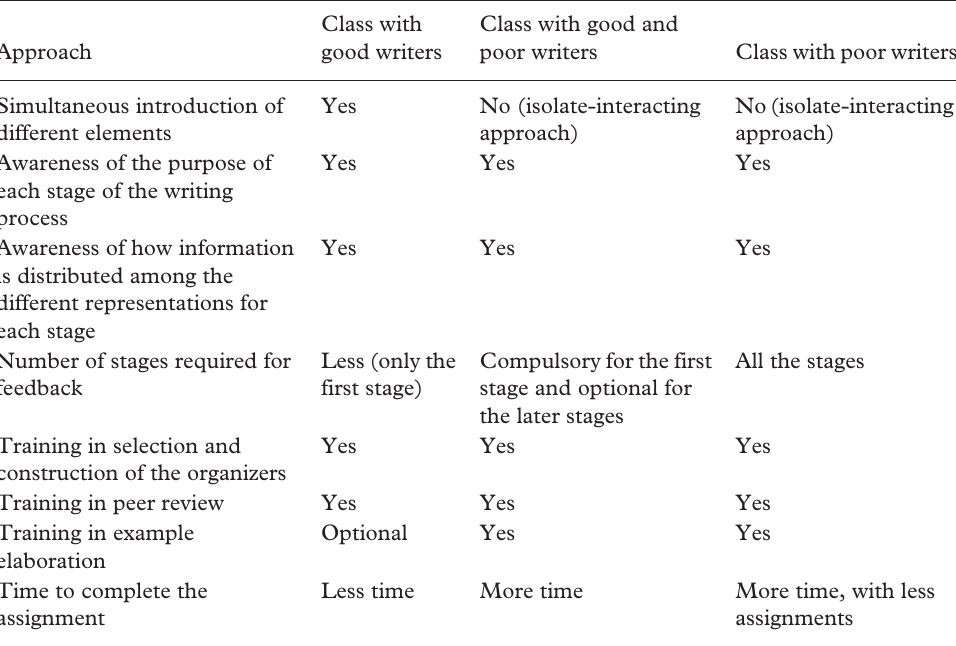
Table 2. Instructional approaches for classes according to students’ writing ability Class Approach